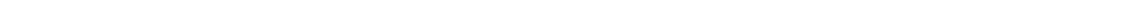
Fig. 6 Enhanced anticancer capacity of LSC-P and LSC-C nanoparticles under NIR laser irradiation in vitro. a – b Photographs and quantitative data of crystal violet assay of 2D-cultured NCI/RES-ADR multidrug-resistant cells a and CSC-enriched NCI/RES-ADR spheres b after treated with free paclitaxel (PTX), free irinotecan (CPT-11), LSC-C nanoparticles, or LSC-P nanoparticles without or with NIR laser (L) irradiation (LSC-C + L or LSC-P + L, 1 W cm − 2 for 1 min). Error bars represent s.d. ( n = 3). c Both 2D-cultured NCI/RES-ADR cells and CSC-enriched NCI/RES-ADR spheres were cultured with empty LSC nanoparticles (0.2 mg ml − 1 ) for 12 h. After laser irradiation (1 W cm − 2 for 1 min), the cells were further cultured with free PTX or CPT-11 dissolved (with the aid of 1% DMSO) in fresh medium for 24 h, showing the free PTX or CPT − 11 could induce more cytotoxicity compared with the free drugs treated cells in a – b . This is probably owing to the inhibition of drug resistance ability of the cells after the combined treatment of LSC nanoparticles and laser (LSC + L). Error bars represent s.d. ( n = 3). d – e Distribution of PTX-F (PTX labeled with fl uorescein isothiocyanate ( d ) or CPT-11 ( e ) in free PTX-F or CPT − 11, LSC + L treatment with free CPT-11 or PTX-F (LSC + L, + C or LSC + L, + PF), and LSC-C or LSC-PF treated multidrug-resistant cells. The results of both CPT-11